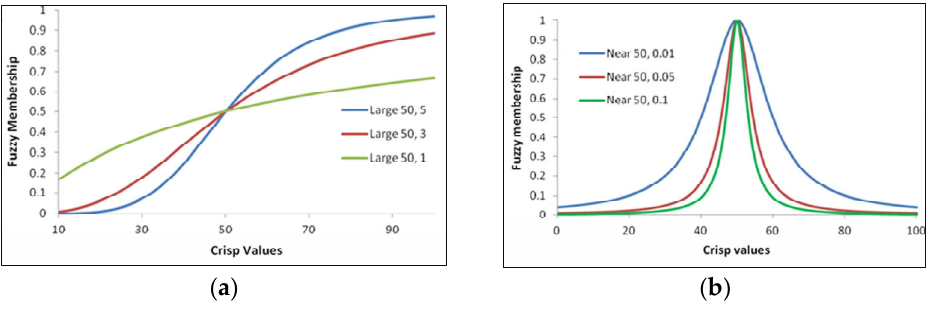
Figure 3. ( a ) Fuzzy large membership; ( b ) fuzzy near